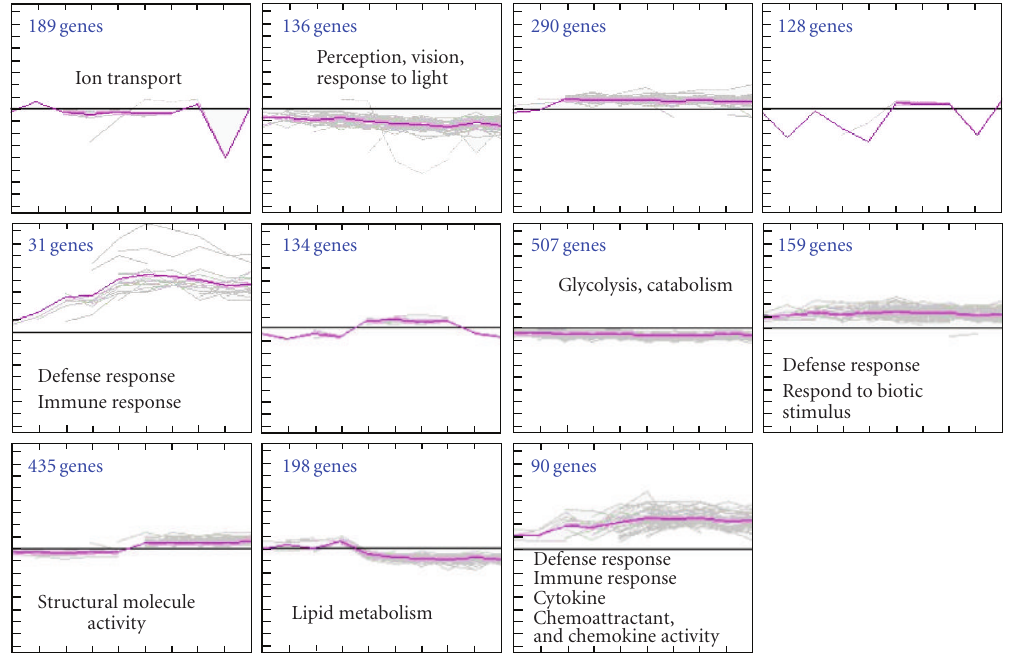
Figure 3: CLASSIFI analysis was performed on mutant (Rhok − / − /Sag − / − ). The significant cuto ff use for this CLASSIFI analysis was 2.17 × 10 − 5 , estimated using the Bonnferoni correction with an alpha of